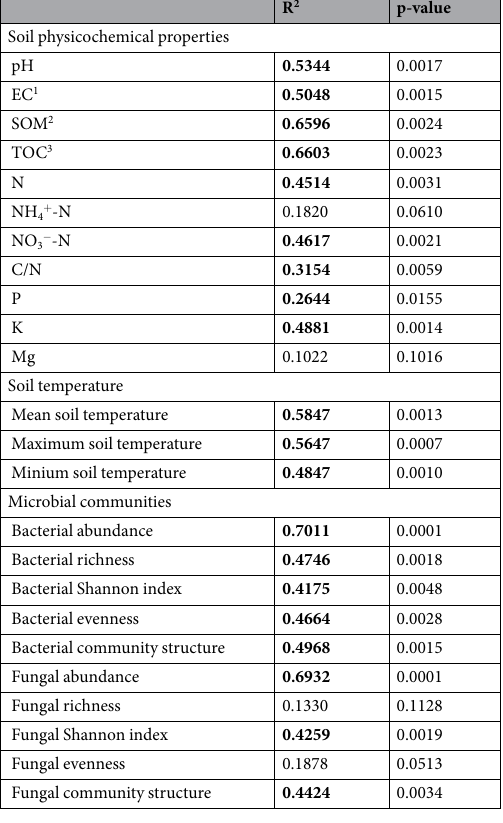
Table 4. Mantel test results correlating microbial functional gene community structure based on Geochip 5.0 found at the deciduous forest site M (545–570 m asl) and the coniferous forest site R (1,724–1,737 m) in spring and autumn with soil physicochemical properties, soil temperature measurements and taxonomic properties of bacterial and fungal communities. R 2 values in bold indicate statistical significance (p ≤ 0.05). 1 EC, electrical conductivity. 2 SOM, soil organic matter. 3 TOC, total organic